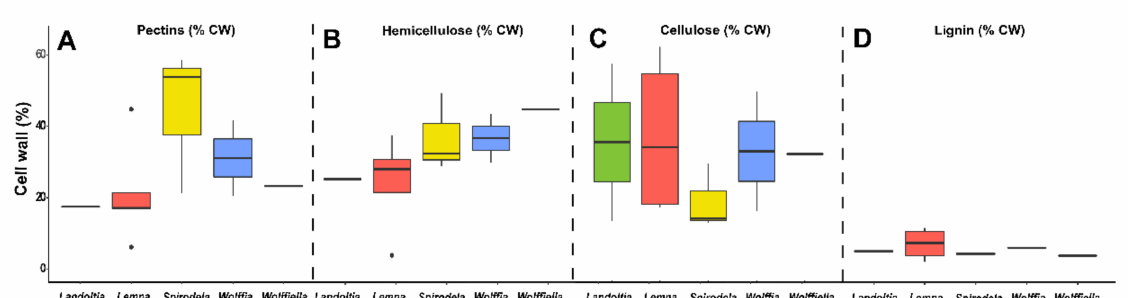
Figure 5. Cell wall polysaccharides and lignin levels of duckweeds. ( A ) Pectins (% cell wall). ( B ) Hemicellulose (% cell wall). ( C ) Cellulose (% cell wall). ( D ) Lignin (% cell wall). The proportion of cellulose in duckweeds (13–17%) is thought to be three times